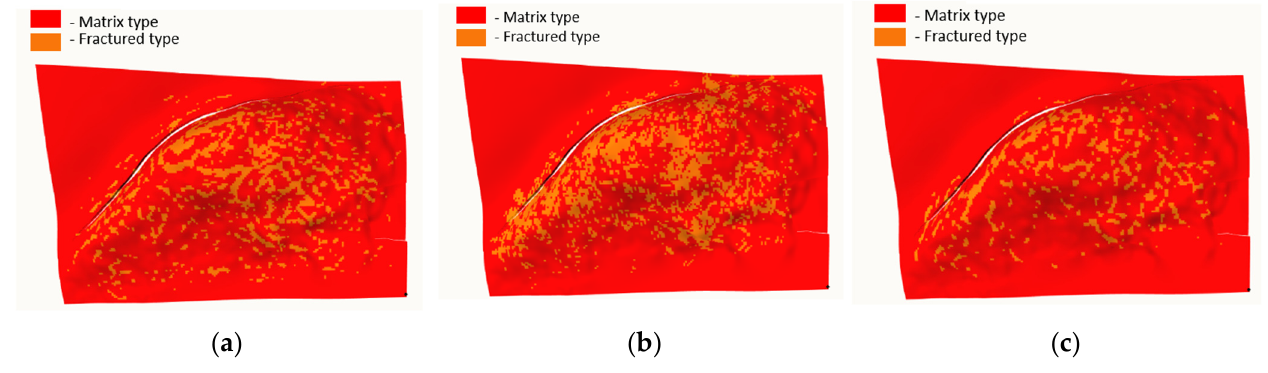
Figure 1. Classification of the reservoir in the volume according to the aperture of the distribution of